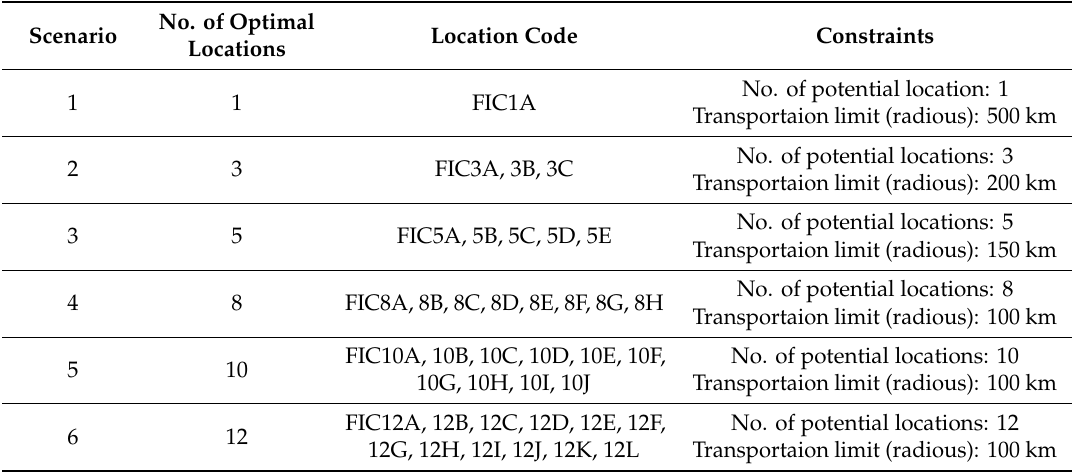
Table 5. Six scenarios analyzed to investigate the most e ffi cient number of potential forest industry clusters (FIC)